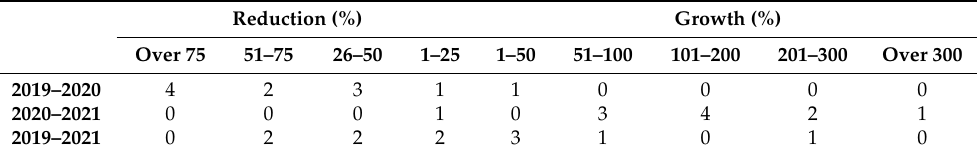
Table 6. Variation in the number of canyoning customers in the